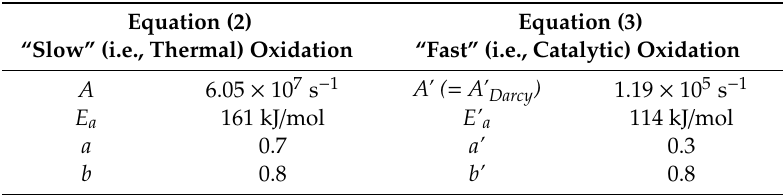
Table 1. Kinetic parameters for Equations (2) and (3) (from Reference [19]).